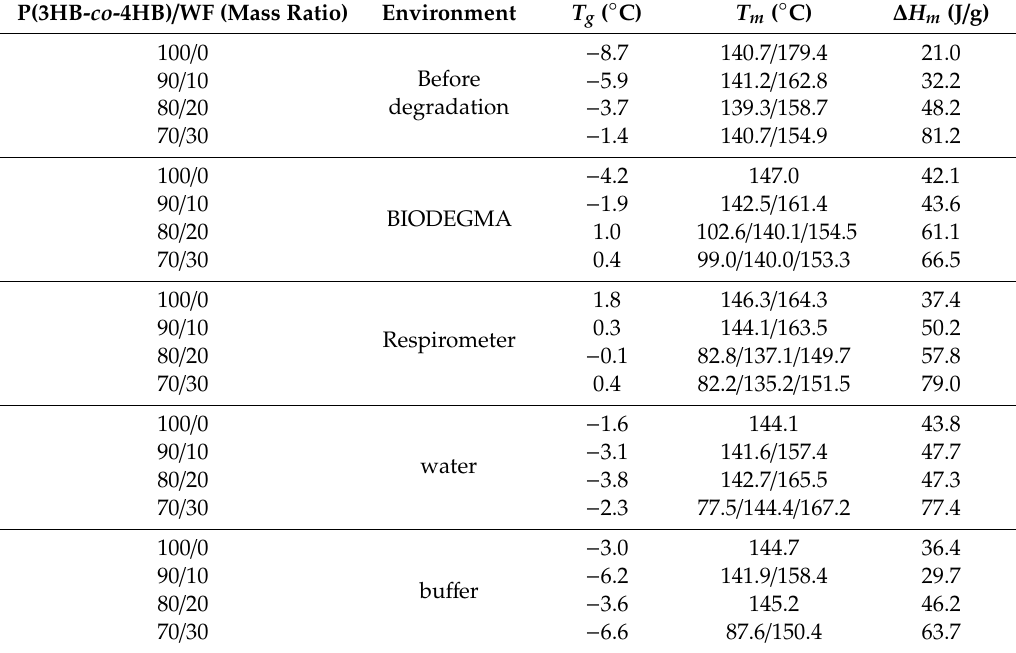
Table 5. Calorimetric parameters of neat P(3HB- co -4HB) and P(3HB- co -4HB) / WF composites before and after 21 days of degradation in di ff erent environments, 20 ◦ C / min; T m —melting temperature and ∆ H m —melting enthalpy (first heating scan), T g (second heating scan after rapid cooling) (thermograms in the Supplementary Material Figure